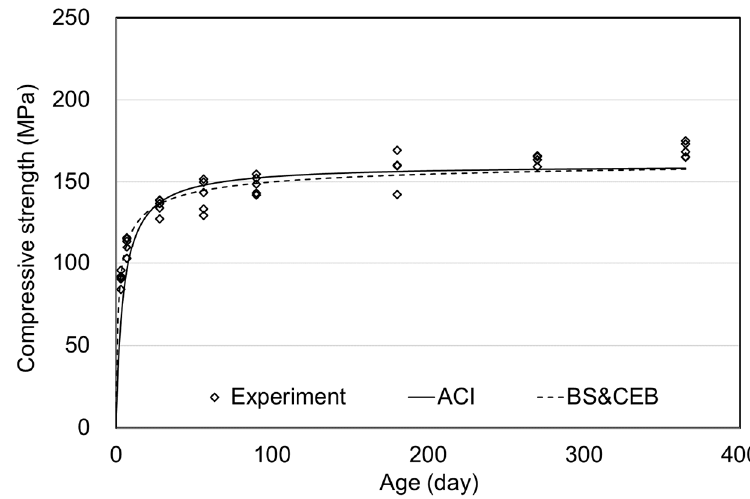
Figure 4. Comparative results of air curing compressive strength.